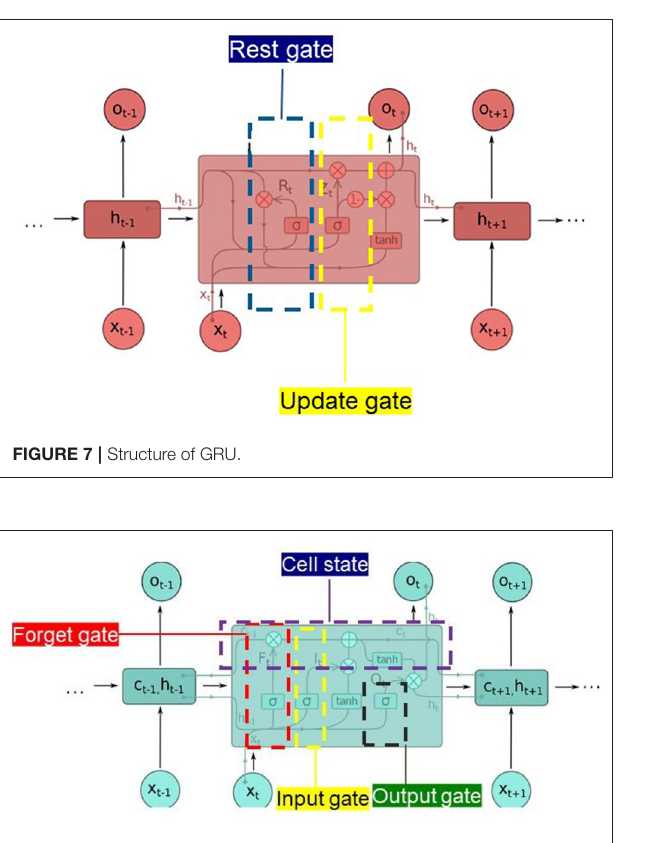
FIGURE 8 | structure of LSTM